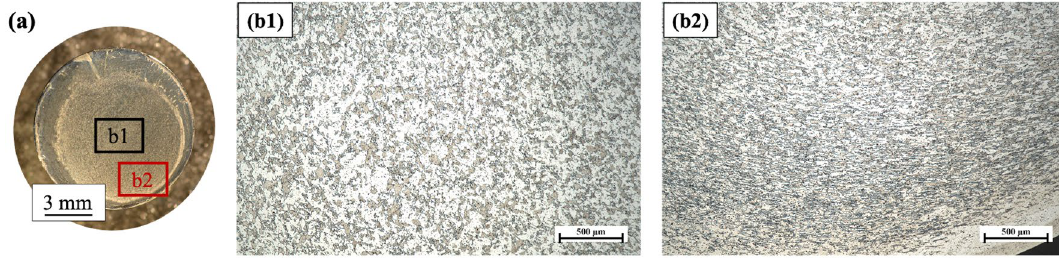
Fig. 6 Grain structure analysis of AA7075-T651 in AR state: ( a ) Macroscopic image of the surface perpendicular to the extrusion axis, ( b1 ) OM image of region b1 shown in ( a ), and ( b2 ) OM image of region b2 shown in ( a